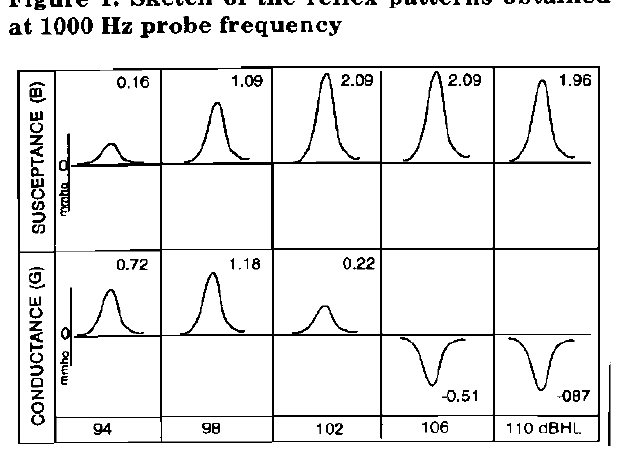
Figure 1. Sketch of the reflex patterns obtained